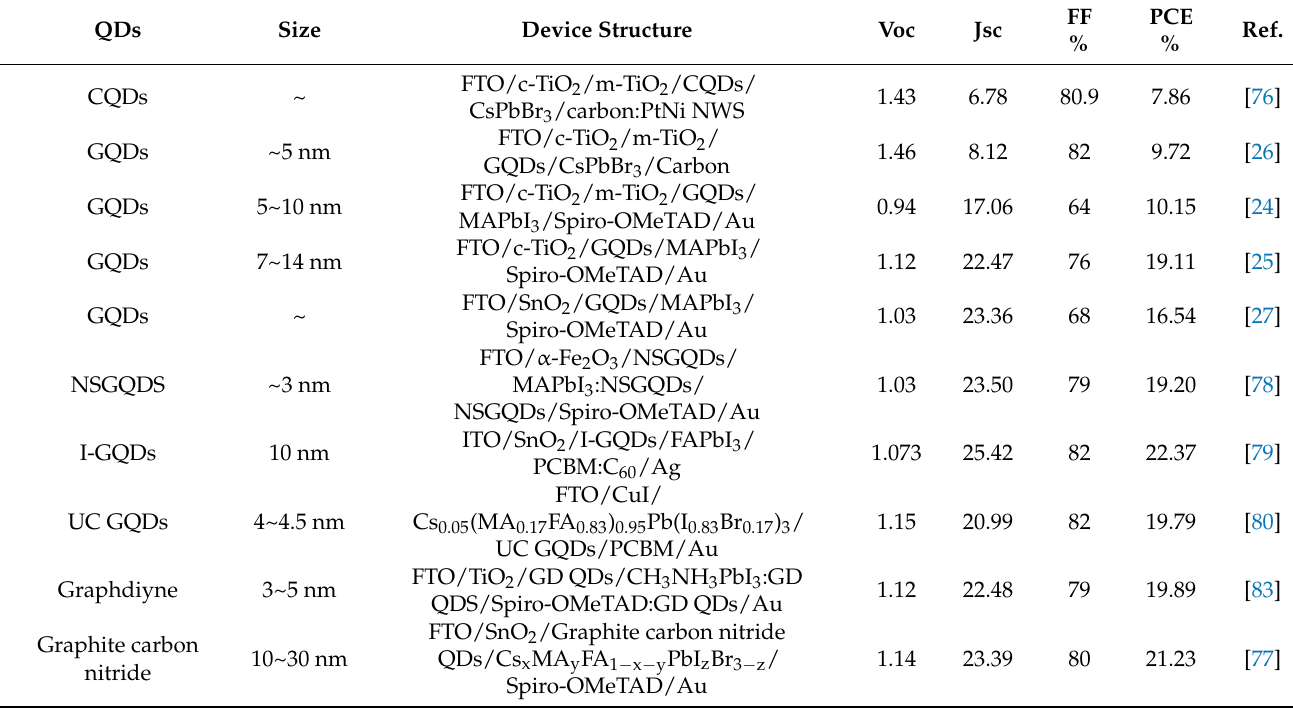
Table 1. Details of CQDs and GQDs as the perovskite/ETL interface